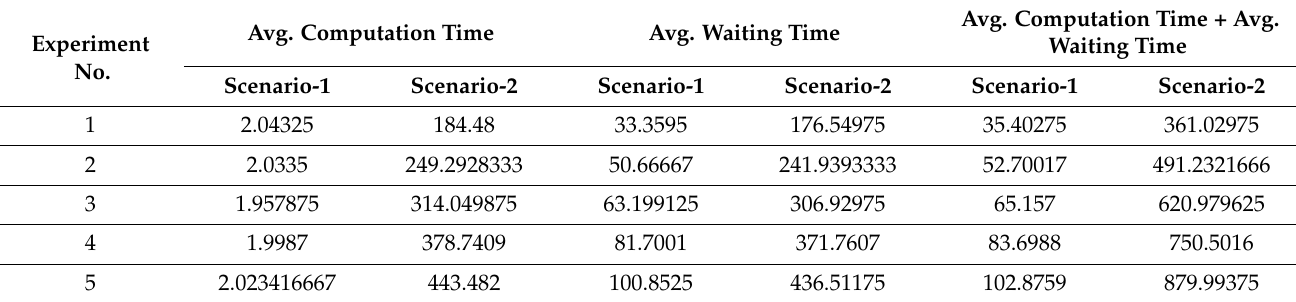
Table 7. Comparative analysis based on computation time (ms) and waiting time (ms).